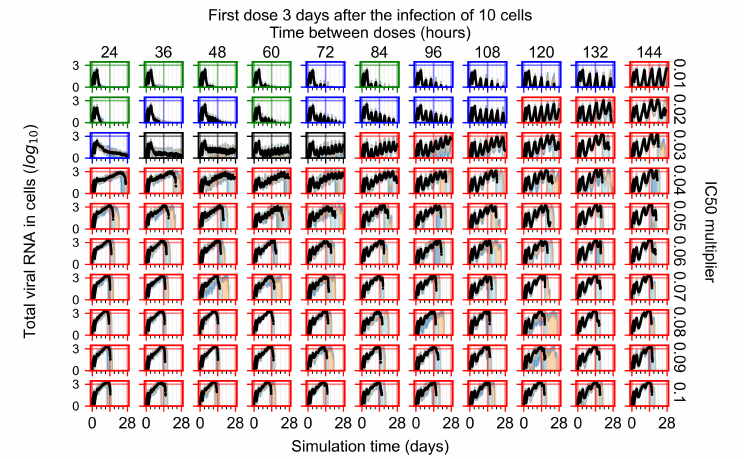
Figure A64. Amount of viral RNA in infected cells (arbitrary units), Y axis in log scale, and exponent values as tick